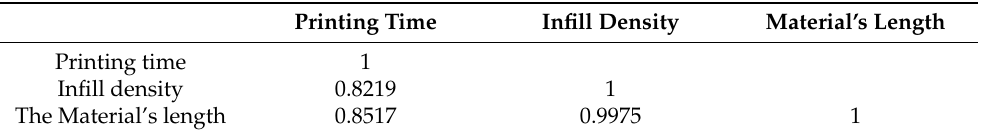
Table 1. Correlation between parameters. Printing Time Infill Density